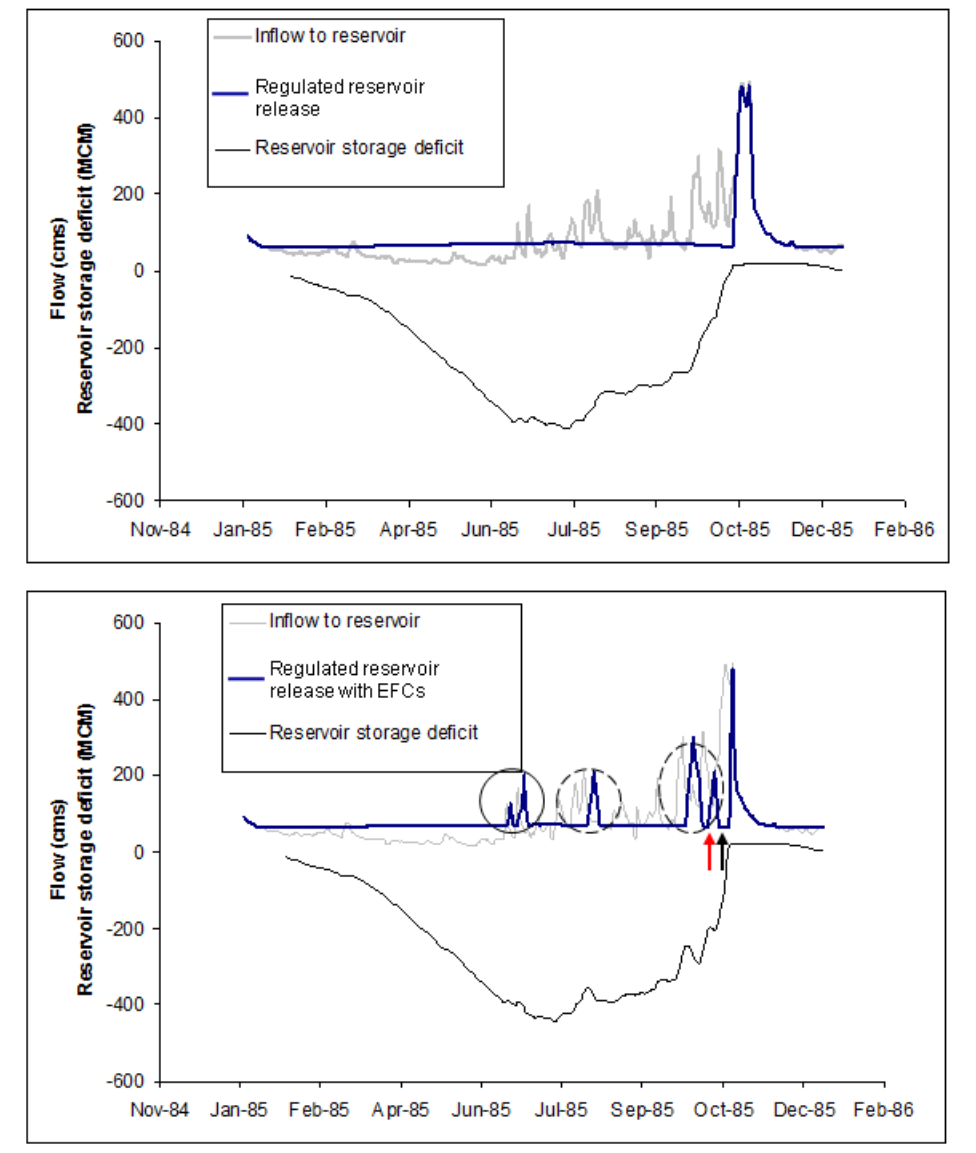
Fig. 8. Results of our reservoir-filling mass-balance model. Top graph shows hydrology for 1985 (one of the driest years in the record), showing unregulated (inflow to reservoir; light gray), regulated (simulated outflow with dam operation; thick blue), and reservoir storage deficit (thin black line). The bottom graph shows an implementation scenario for an environmental flow regime for the same year that includes two early wet-season high-flow pulses (in solid circle) and three mid wet-season high-flow pulses (within dashed circles). These pulses delay reservoir filling by only 8 d. The red arrow indicates the day that the reservoir would have refilled under the regulated flow regime, and the black arrow indicates the day the reservoir would have refilled under the recommended environmental flow regime. MCM = million cubic